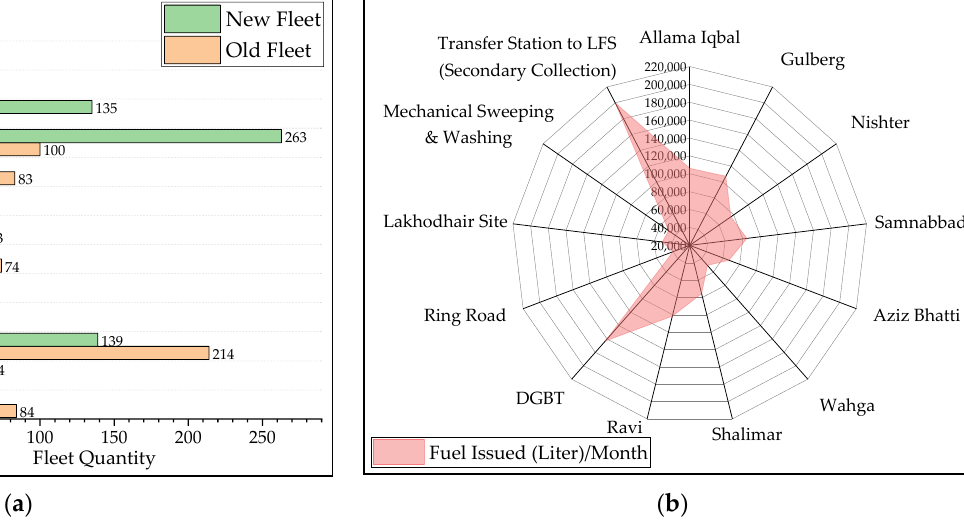
( d ) Figure 10. Equipment and machinery for waste collection: ( a ) Fleet quantity to perform city cleaning operations; ( b ) Town-wise consumption of fuel/month to perform cleanliness operations; ( c ) In- house fabrication of waste storage containers; ( d ) New fleet added in the system to improve collec- tion efficiency. 3.5. Outsourcing of Secondary Collection by LWMC Waste collected by the LWMC fleet is being hauled at designated 20 TCPs/transfer stations (Figure 11a,c,d). In addition, secondary waste collection services from TCPs to the